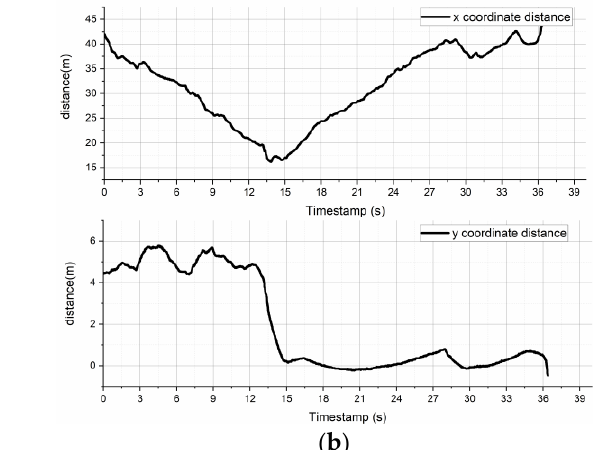
Figure 21. Speed and relative distance of real vehicle test 1: ( a ) queue vehicle speed without flexible following factor or flexible fading factor; ( b ) queue vehicle transverse–longitudinal trajectory without the flexible following factor or flexible decay factor.